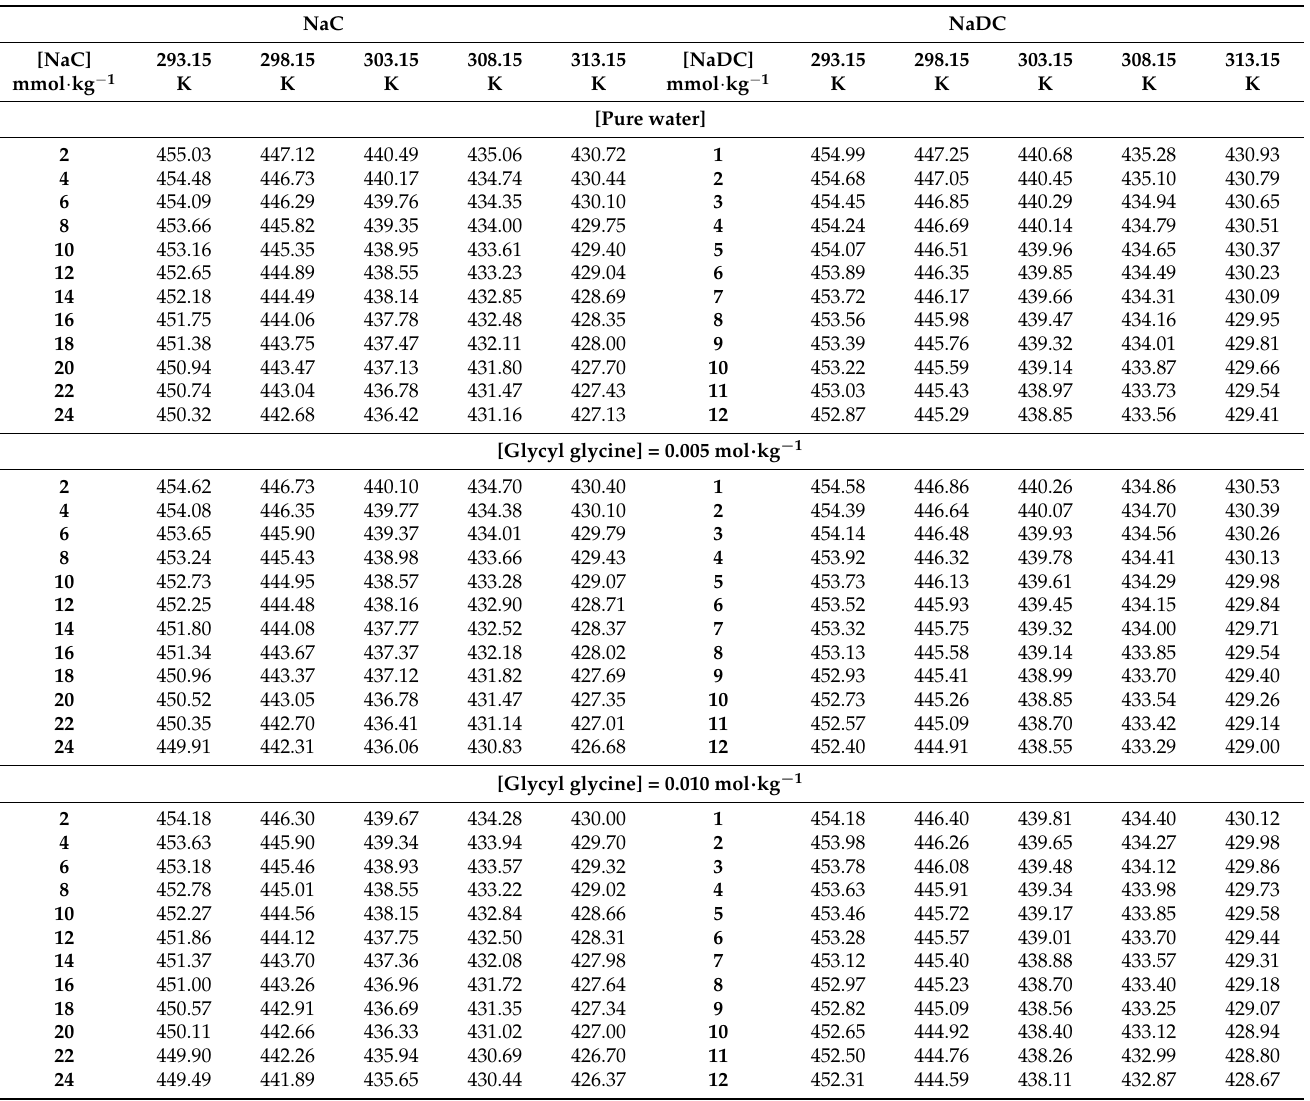
Table 2. Isentropic compressibility, κ s (TPa − 1 ) values for NaC and NaDC in pure water and